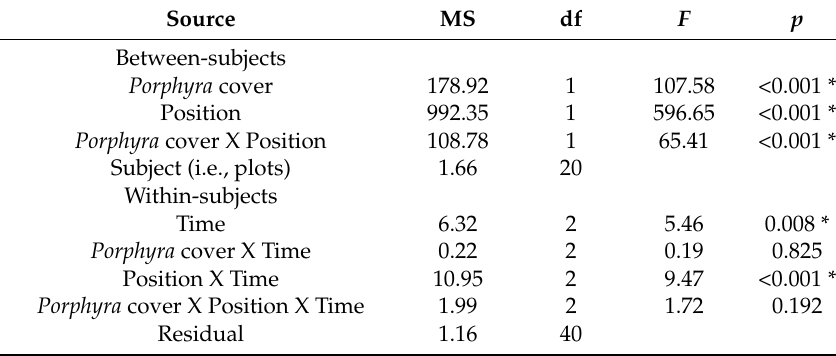
Table 2. Repeated-measures ANOVA model relating the temperature of a standard material (plastic cards wrapped in black electric tape) with Porphyra cover (Yes/No), Position of the plastic card (Above/Underneath the mussel layer), and the Time of measurement (12:30, 2:00, and 3:30 p.m.). Asterisks indicate significant